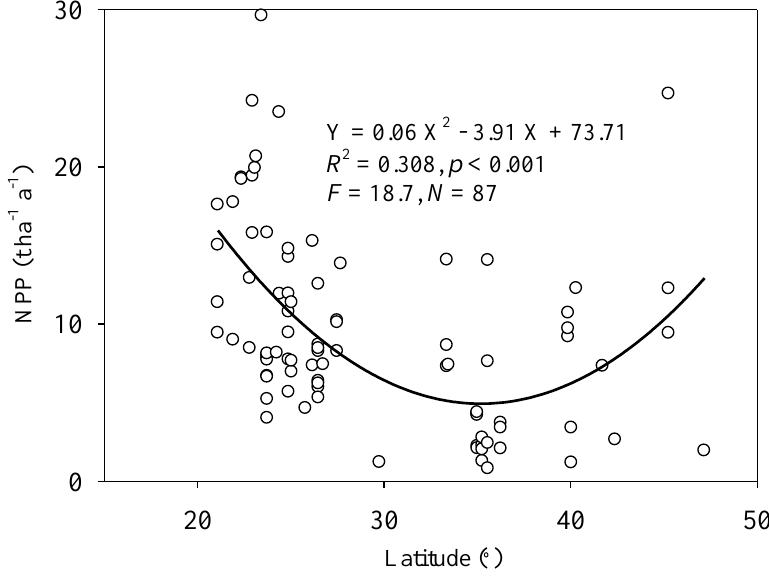
Figure 2. Trends of net primary productivity (NPP) along latitude for forest ecosystems in eastern China. N, number of observations; F , F Values. Table 1. Comparisons of net primary productivity (NPP) of forest ecosystems in different climate zones. Tropical zone: <23.0° N; Subtropical zone: 23.0 – 33.0° N; Temperate zone: 33.0 – 45.0° N; and Boreal zone: >45.0° N. Number of observations (N), mean value (Mean), maximum value (Max), minimum value (Min), standard error (SE), and coefficient of variation (CV) were reported. Differences among climate zones were tested using one- way ANOVA with Fisher’s LSD comparisons; differences at p < 0.05 were indicated with different letters.